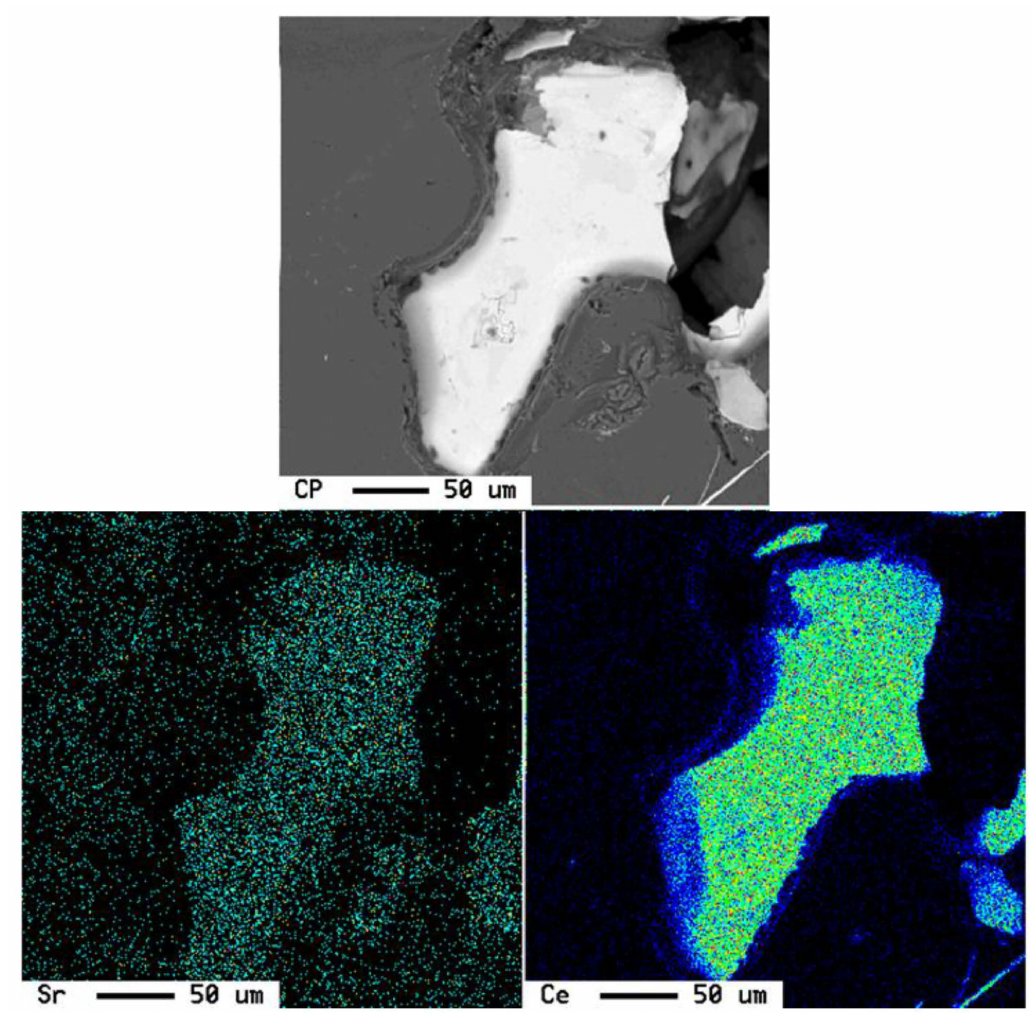
Figure 9. Ce-Sr interactions in A356 alloy modified with 1.0% Ce + 0.01% Sr (T5S